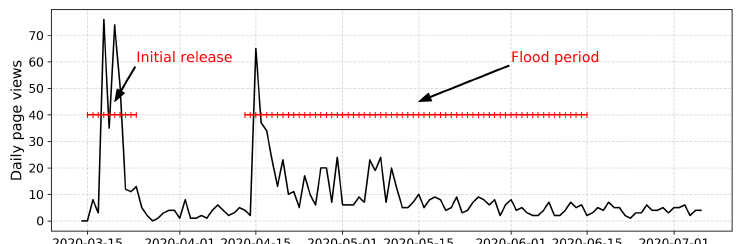
Figure 11. Daily attendance of the OpenForecast main webpage